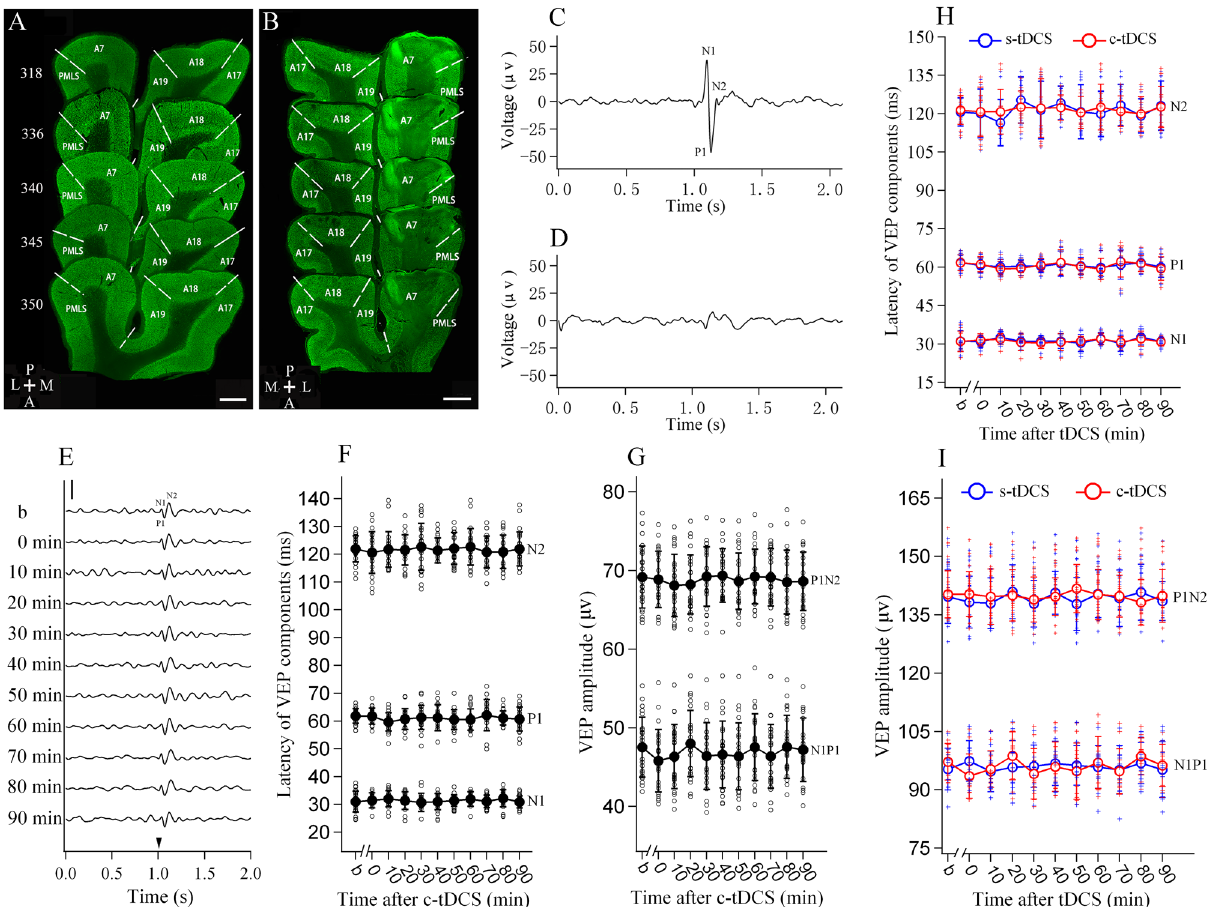
Figure 4. Showing effects of c-tDCS in the lesioned area 7 (A7) as well as c- and s-tDCS in the nonvisual cortex of area 5 (A5) on VEPs in the V1 cortex (area 17). ( A – G ) Effects of c-tDCS in A7 on VEPs in the V1 cortex after inactivation of neuronal activity in A7 by electrolytic lesions. A&B are samples of section images showing the morphology of normal A7 ( A ) and A7 with electrolytic lesions ( B ). The number on the left of each section indicates section number counted along the posterior-to-anterior (A–P) direction. The broken lines between A17, A18, A19, A7 and PMLS show estimates of the border between these area. The scale bar equals to 1000 μm. C&D show voltage traces of wave N1, P1 and N2 components of VEPs measured in A7 before and after electrolytic lesions, respectively. The pre-stimulus time is 1.0 s. (E) VEP voltage trace samples measured before (b) and at different time (0–90 min) after the end of c-tDCS in the lesioned A7. The solid vertical bar equals to 100 μv, and the arrowhead indicate the onset of visual stimulation. F&G show respectively the latency of wave N1, P1 and N2 as well the peak-to-peak amplitude of N1P1 and P1N2 of VEPs in the V1 cortex measured before (b) and at different time (0–90 min) after c-tDCS in the lesioned A7. The solid circles with error bars (mean ± SDs) indicate average value across four cats. The small open circles represent individual data point of 24 repeated measurements (6 repeated measures/cat). H&I show respectively the latency of wave N1, P1 and N2 as well the amplitude of N1P1 and P1N2 of VEPs in the V1 cortex measured before (b) and at 0–90 min after s- and c-tDCS in A5. The open color circles indicate average value across two cats. The color crosses represent individual data point of 12 repeated measurements. Images created using FV10-ASW (version 03.01.02.02, Olympus Corporation, www. olymp us- sis. com), Igor (version 6.3.1.2, www. wavem etrics.